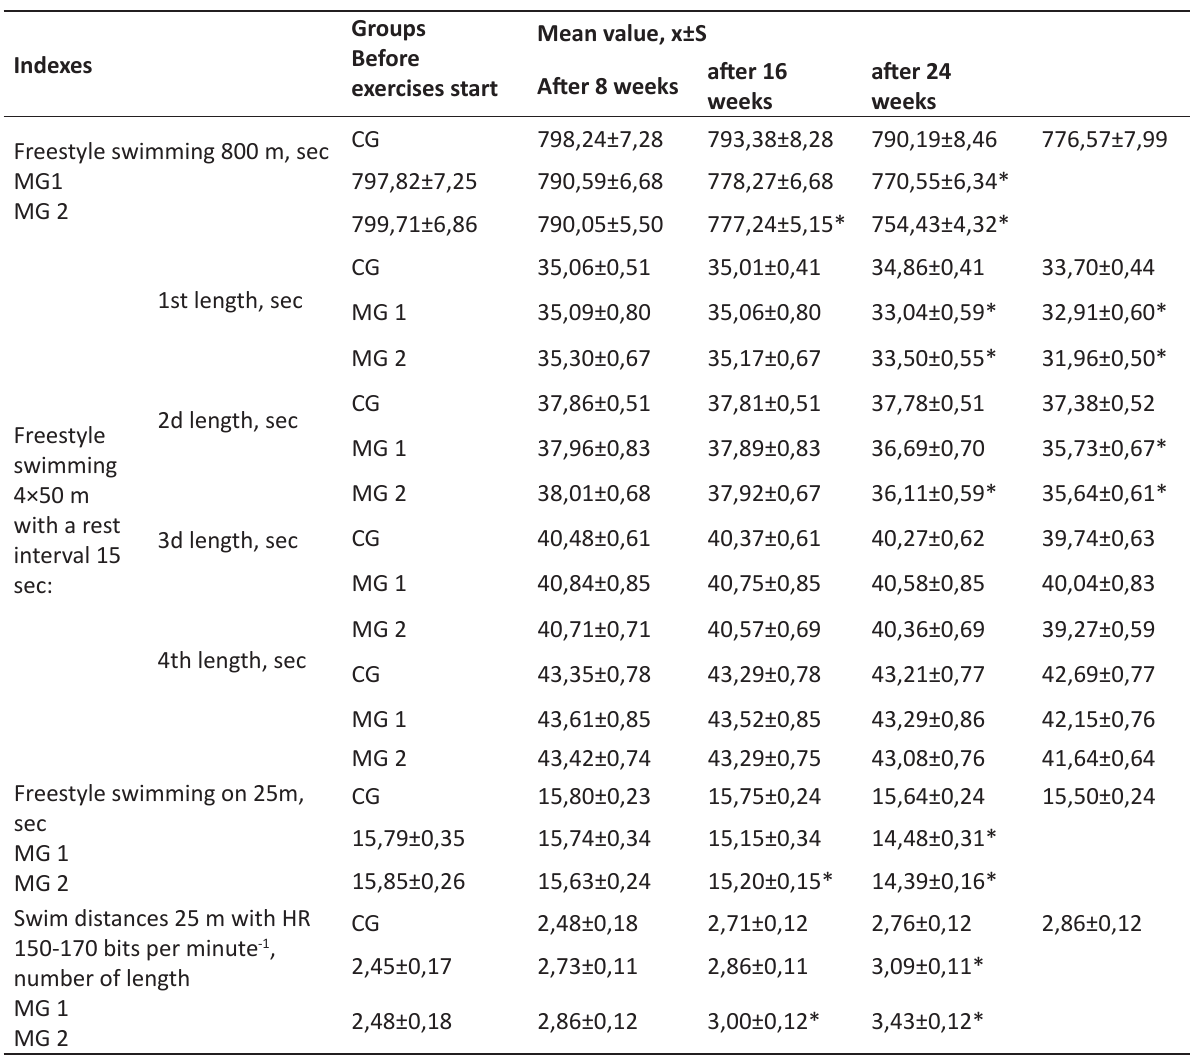
Table 1. Indicators of special physical fitness of 11-12 years old swimmers at different stages of the study (CG, n = 21, MG1, n = 22, MG2, n =